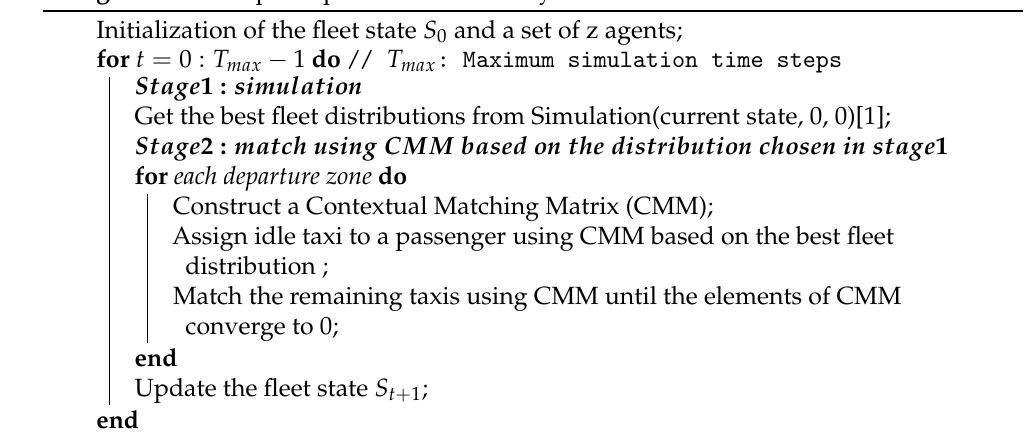
Algorithm 3: Dispatch process in M-Greedy